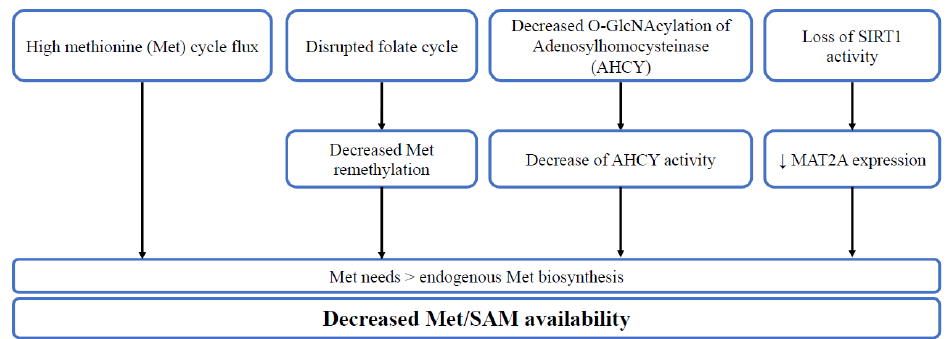
Figure 2. The diverse mechanisms leading to decreased Met/SAM availability. High methionine cycle flux, disrupted folate cycle, decreased O-GlcNAcylation of adenosylhomocysteinase (AHCY) or loss of SIRT1 activity lead to higher methionine needs in comparison to endogenous synthesis, thus decreasing methionine/SAM availability.